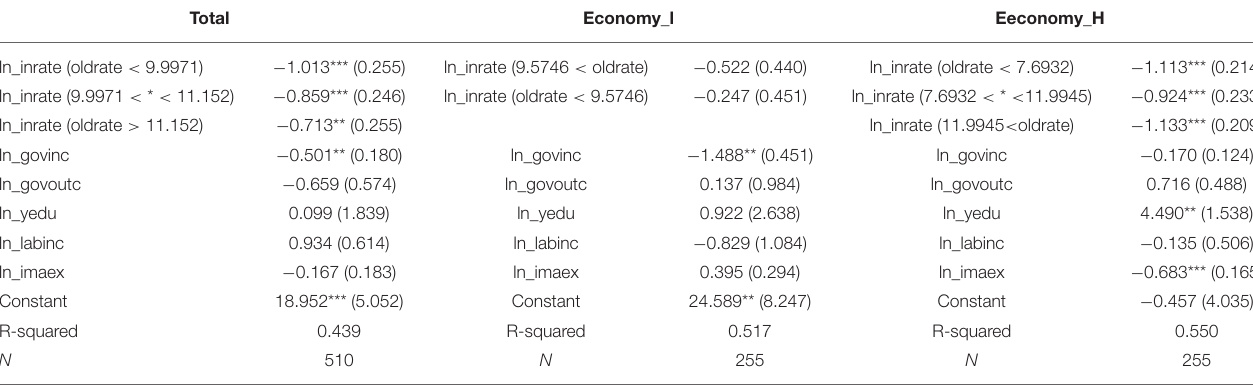
TABLE 9 | Robustness check_ estimated